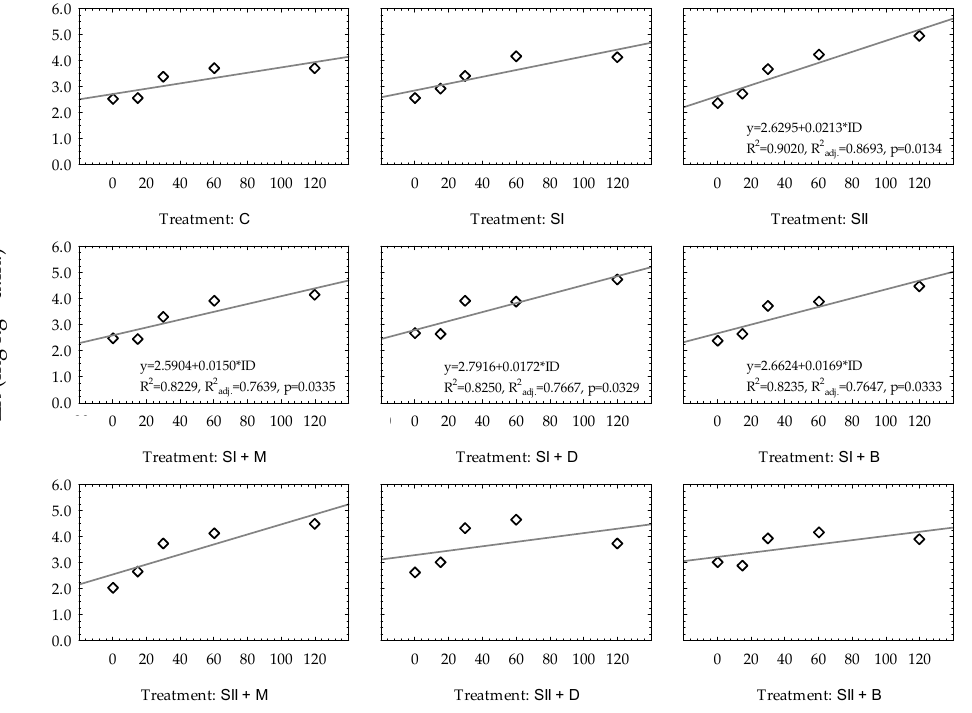
Figure 4. Linear regression models of Zn changes over time based on experimental treatments in heavy soil. Regression equations are presented only when p ≤ 0.05. * constitute a multiplication mark.